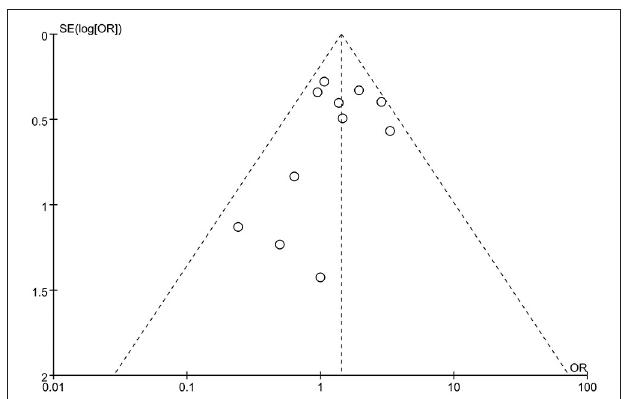
FIGURE 7 | Funnel plots for postoperative pancreatic